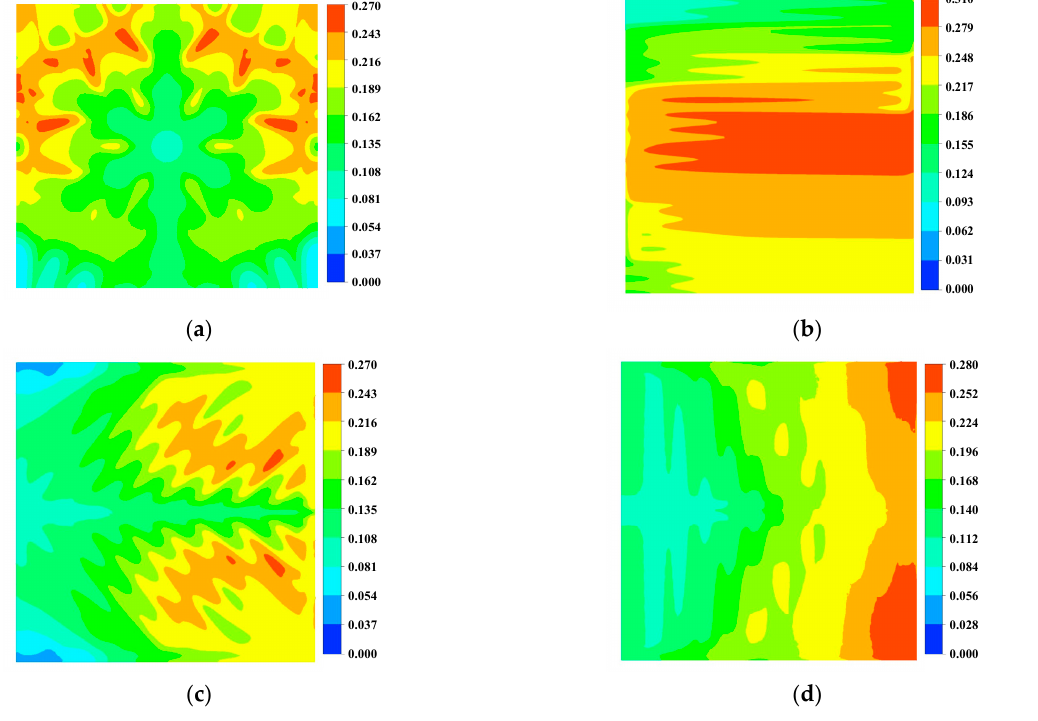
Figure 8. Water mass fraction in cathode diffusion layer (0.8 V): ( a ) Snowflake bionic flow channel; ( b ) dual serpentine flow channel; ( c ) leaf-shape bionic flow channel; ( d ) lung-shape bionic flow channel.